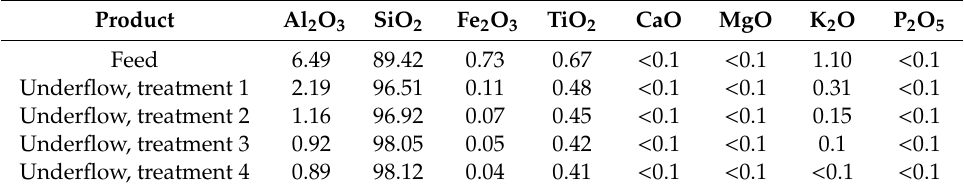
Table 8. Underflow fraction results after 3